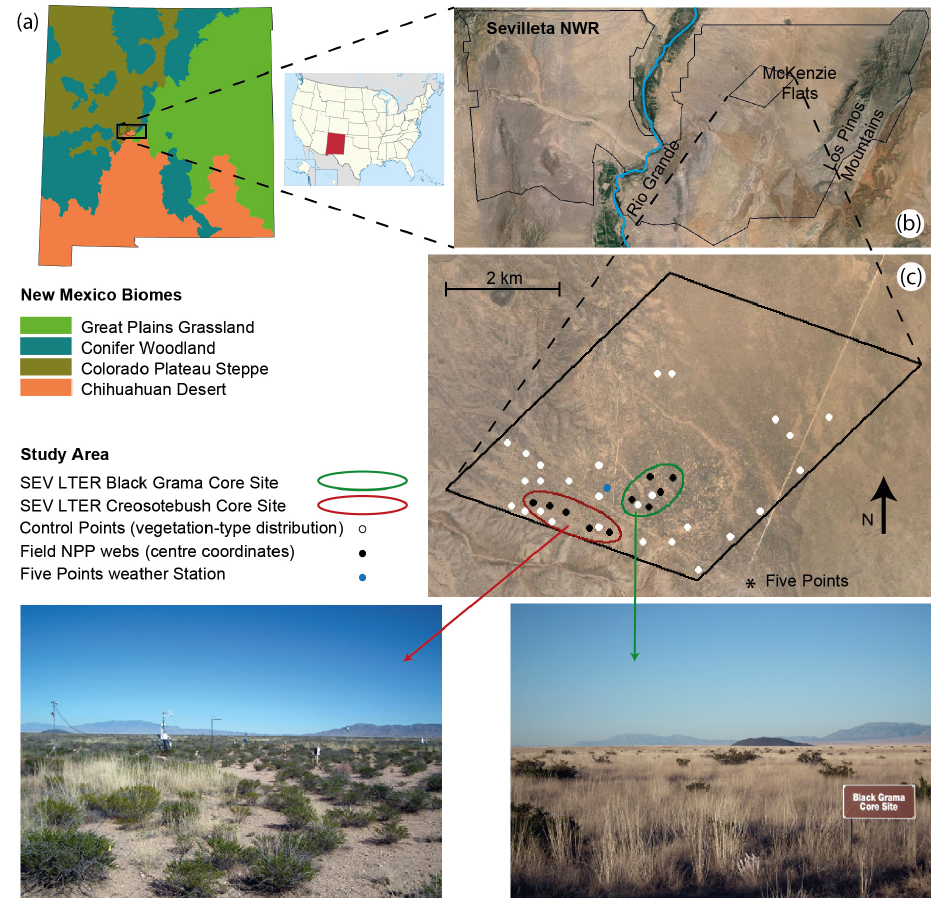
Figure 2. Study area: (a) location of the Sevilleta National Wildlife Refuge (SNWR) and distribution of major New Mexico biomes, (b) regional location of the study area (McKenzie Flats, SNWR), and (c) detailed location of the study site (18km 2 area) and general view of the reference SEV LTER Black Grama (right) and Creosotebush (left) core sites. Map (a) follows the Sevilleta LTER classification of New Mexico biomes (Sevilleta LTER, http://sev.lternet.edu/content/new-mexico-biomes-created-sevlter). Source for background image in panels b) and (c) : 2009 National Aerial Imagery Program (USDA Farm Service